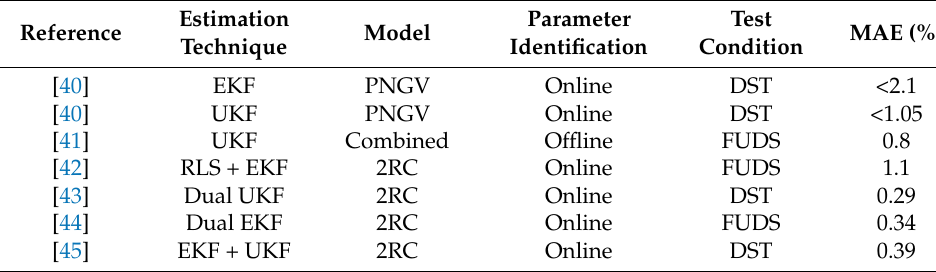
Table 3. Summary of Kalman Filter (KF)-based estimation techniques and battery modelling